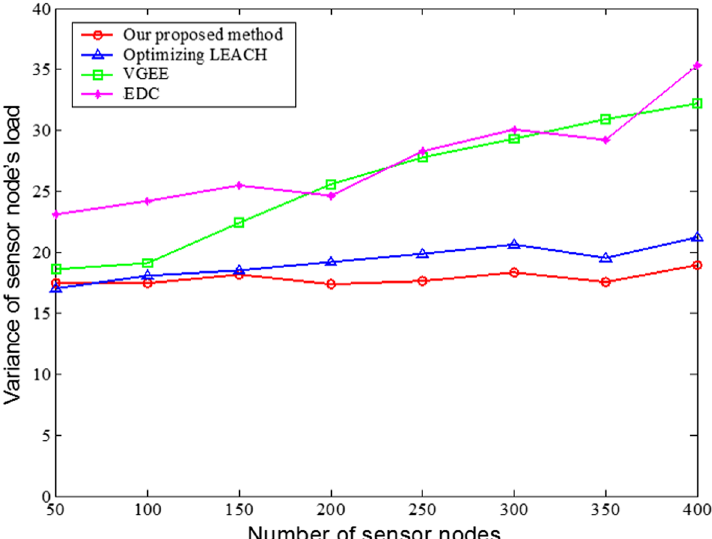
Fig. 4 Comparison of node’s load